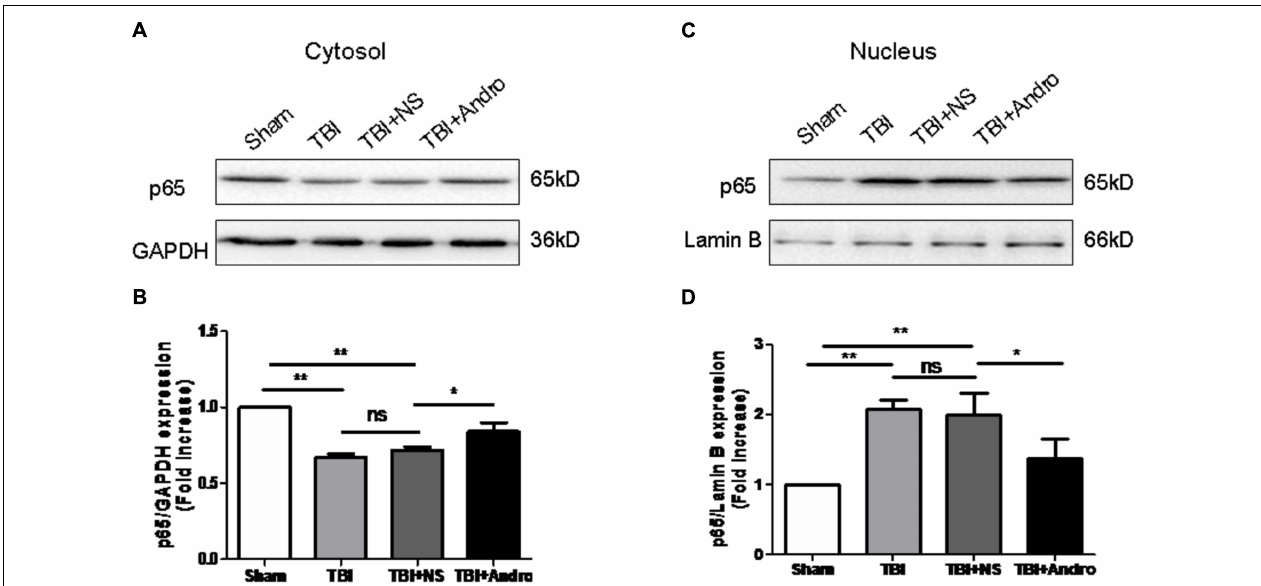
FIGURE 5 | Andro treatment suppressed NF- κ B translocation from the cytosol to the nucleus after TBI. Both cytoplasmic (A) and nuclear (C) protein were extracted in peri-contusive cortex at 24 h after TBI. The expression levels of NF- κ B p65 were examined by Western blot analysis. Relative expression levels of NF- κ B p65 in cytoplasmic (B) and nuclear (D) protein were calculated based on densitometry analysis. The mean values of NF- κ B p65 in the sham group were normalized to 1.0. All data are presented as the mean ± SD. ∗ p < 0.05, ∗∗ p < 0.01 ∗∗∗ p < 0.001, ns p > 0.05; n = 6 in each